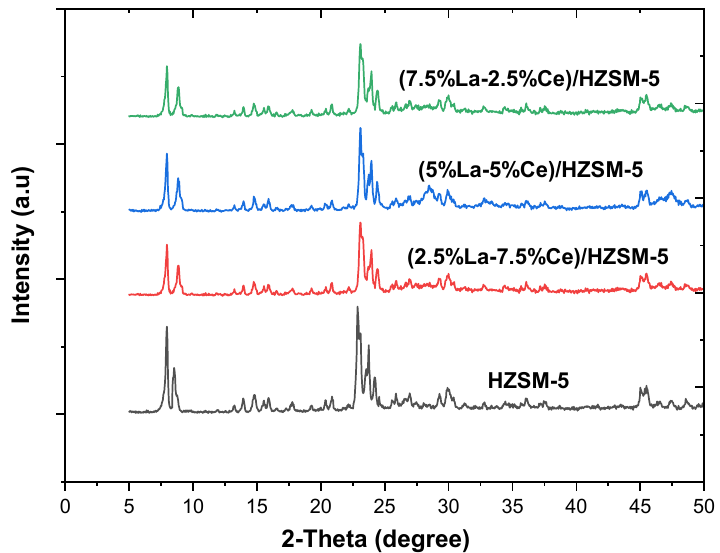
Figure 6. XRD patterns for parent HZSM-5 and Lanthanum-Cerium-modified zeolite catalysts. Table 1. The relative crystallinity for parent HZSM-5 and Lanthanum-Cerium-modified zeolite catalysts.